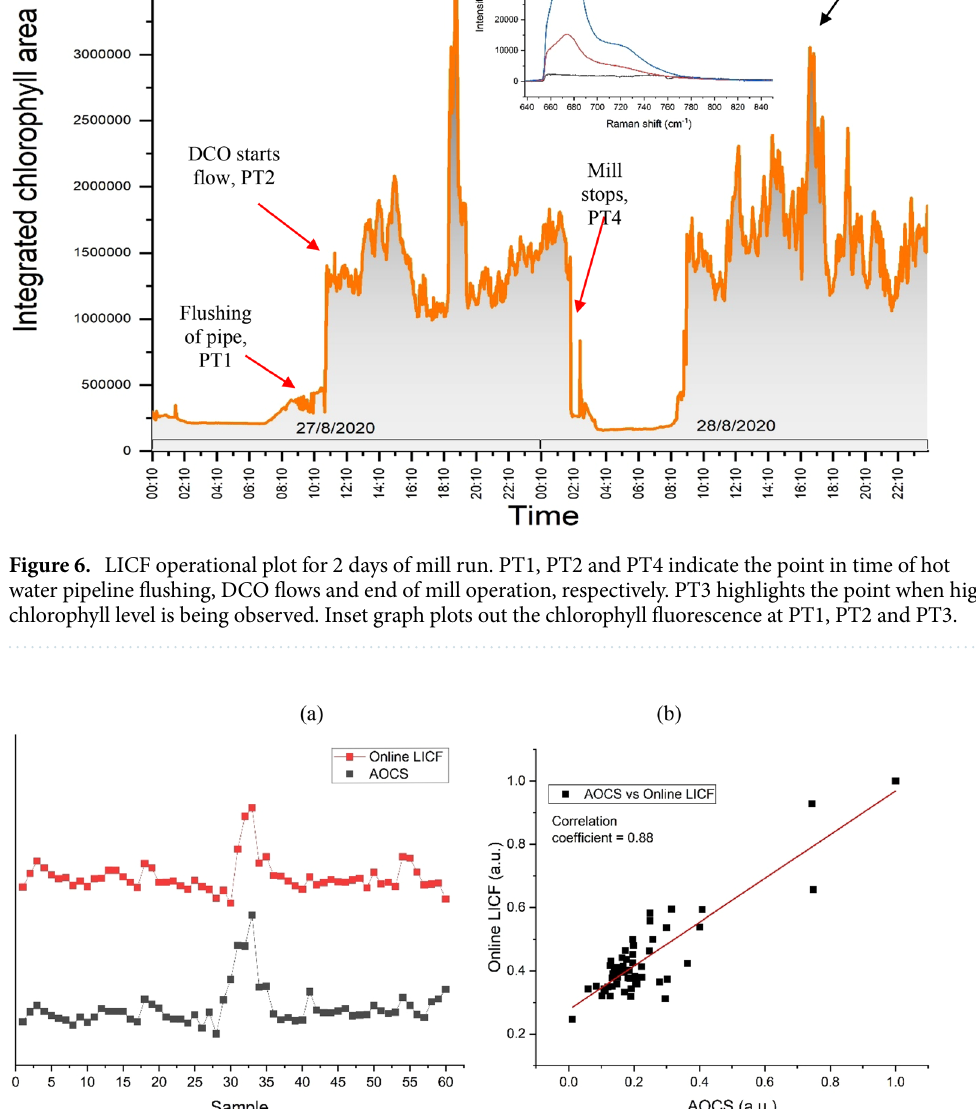
Figure 8 illustrates the principal component (PC) scores plot for 0% unripe FFB (red), 5% unripe FFB (blue) and 10% unripe (green) FFB. Here the LICF spectra from FFB with different level of unripeness can be distin- gushed from each other based on the level of chlorophyll fluorescence. The first two PCs for this dataset address all of the net variance in the spectral dataset. From Fig. 8, all the sample from the 0% unripe FFB cluster tightly together and well-separated from the rest of the samples. This can be explained by the extra low chlorophyll level coming from the 0% unripe FFB samples (red). The LICF spectra from 5% and 10% unripe FFB are also separated from each other with a small portion of overlap. Here the LICF spectra from FFB with different level of unripeness can be distingushed from each other based on the level of chlorophyll fluorescence. The separa- tion of the 10% unripe FFB from the group of 0% and 5% unripe FFB is due to the higher level of chlorophyll fluorescence, as shown in the positive loading 1 plot (blue) in Fig. 9. The separation between 0% unripe and 5% unripe FFB is shown in Fig. 9 the negative loading 2 plot (red), which is due mainly to the higher level of chlorophyll fluorescence from the 5% unripe FFB.